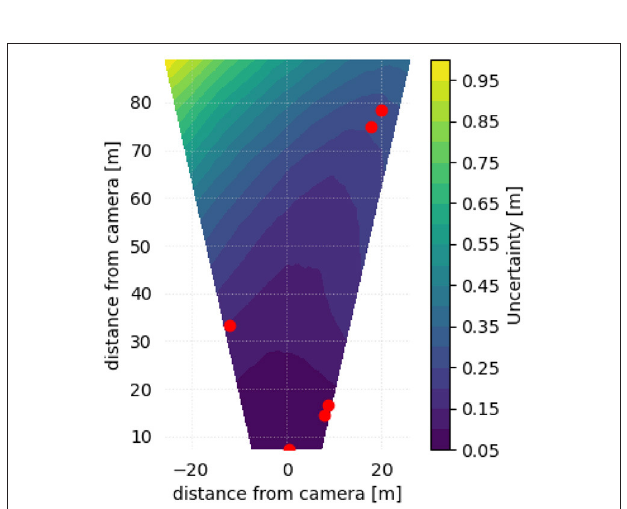
FIGURE 5 | 95th percentile contours of spatial uncertainty, with 6 GCPs (red dots) distributed unevenly within the FOV, resulting from perturbing only the water surface